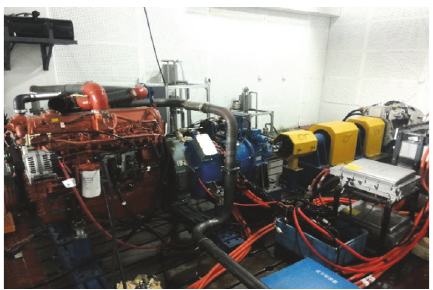
Figure 9: Bench test-bed for new hybrid electric system.